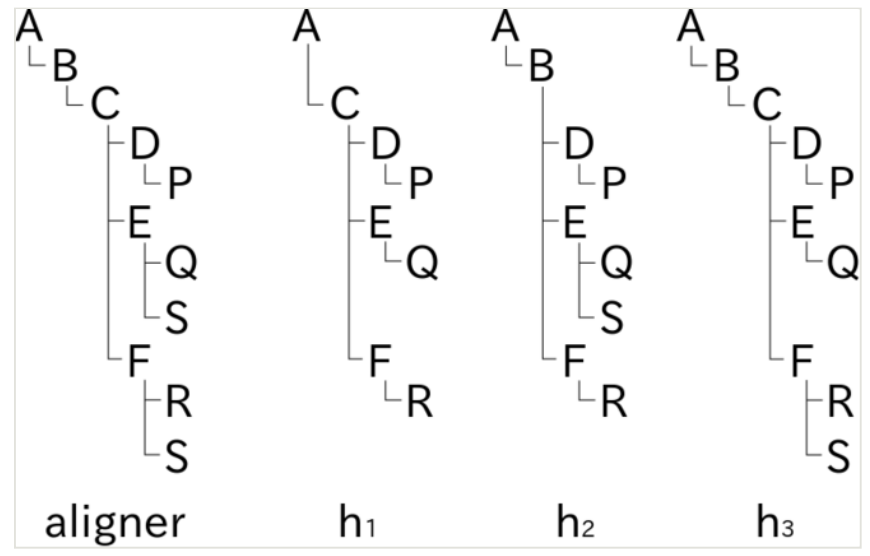
Schematic explanation of aligned rendering of name usages in hierarchies on screen. Name usages in three tree diagrams representing hierarchies, h , h and h are aligned with the aid of an aligner tree. Capital letters in hierarchies represent name usages in each hierarchy. The aligner tree is composed from hierarchies as a kind of superset where letters in the aligner tree are place holders to determine vertical o ff set of nodes. Rendering of a tree diagram in two dimensions based on the folder metaphor requires calculation of node position where horizontal o ff set depends on depth of the node while vertical o ff set is relevant to both depth and width. Nodes in hierarchy diagrams can be aligned horizontally by sharing the calculation of vertical o ff set of nodes. For example, vertical position of node C in hierarchy diagram h is determined by vertical o ff set of node C of the aligner tree while horizontal o ff set is determined in the diagram h alone. Inconsistency between hierarchies results in duplicated nodes in the aligner tree; di ff erent assignments of name usage S in hierarchies h and h results in two S nodes in the aligner tree. Vertical o ff set of nodes S in hierarchies h and h are determined by position of corresponding nodes S in the aligner tree. Missing name usages, e.g. name usages B and S in hierarchy h , result in vacancies in the hierarchy diagrams like vacancy for boundary sets of Rough set representation. Note that such vacancies do not a ff ect the horizontal o ff set in hierarchy